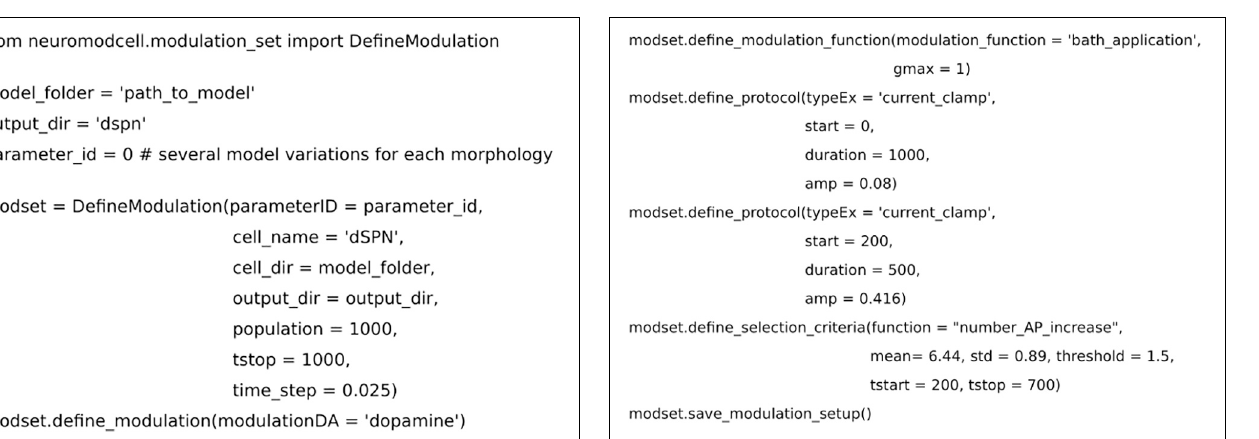
FIGURE 4 | Code for setting up the selection criteria. Dopamine level is simulated as a bath application. Two simulated current clamps are added to the set up to replicate the experiment from Planert et al. (2013). The effect of dopamine is measured by the number of action potentials and compared with experimental